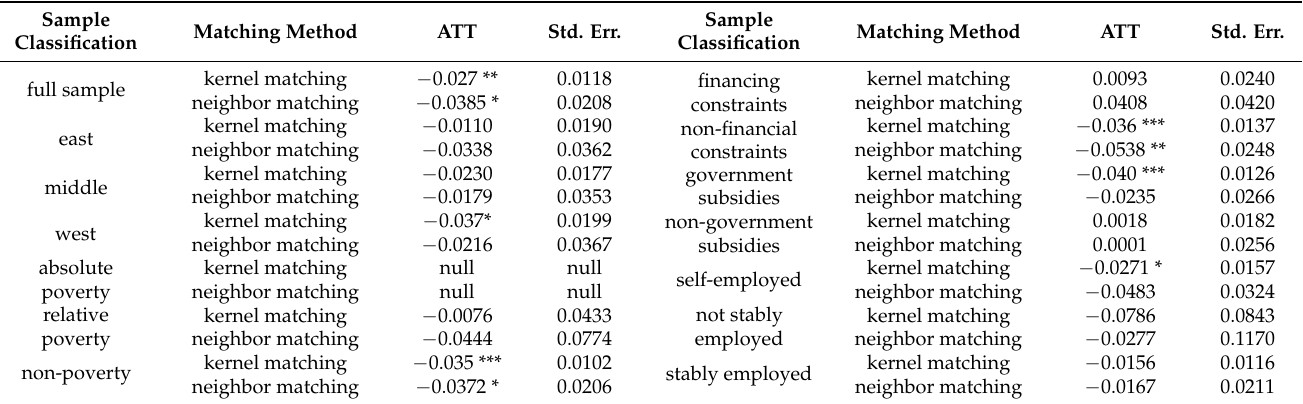
Table 6. PSM method robustness test